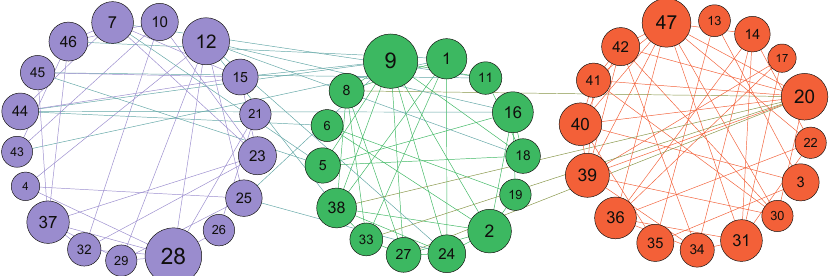
Figure 5. The final community structure of Course registration network according to the NINS algorithm.